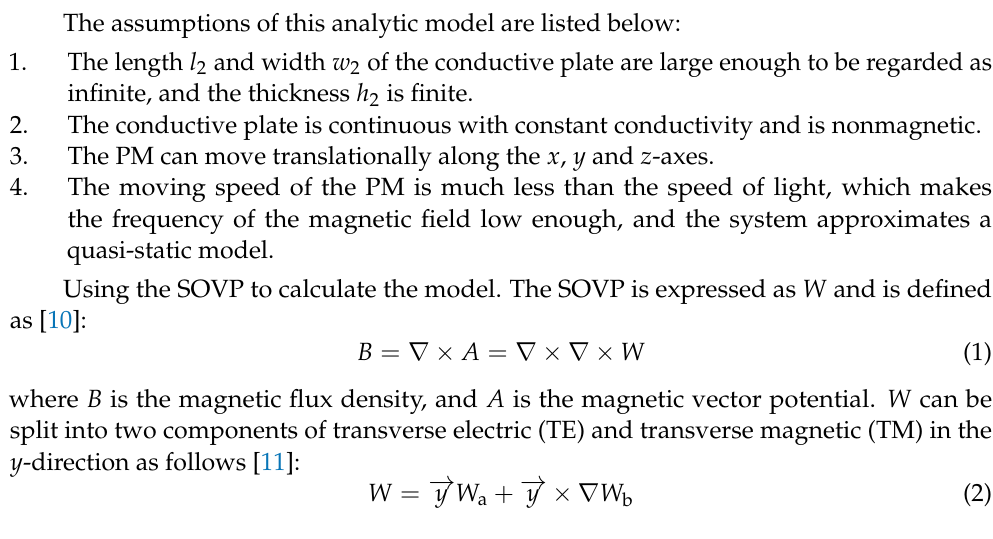
Figure 5. Space region